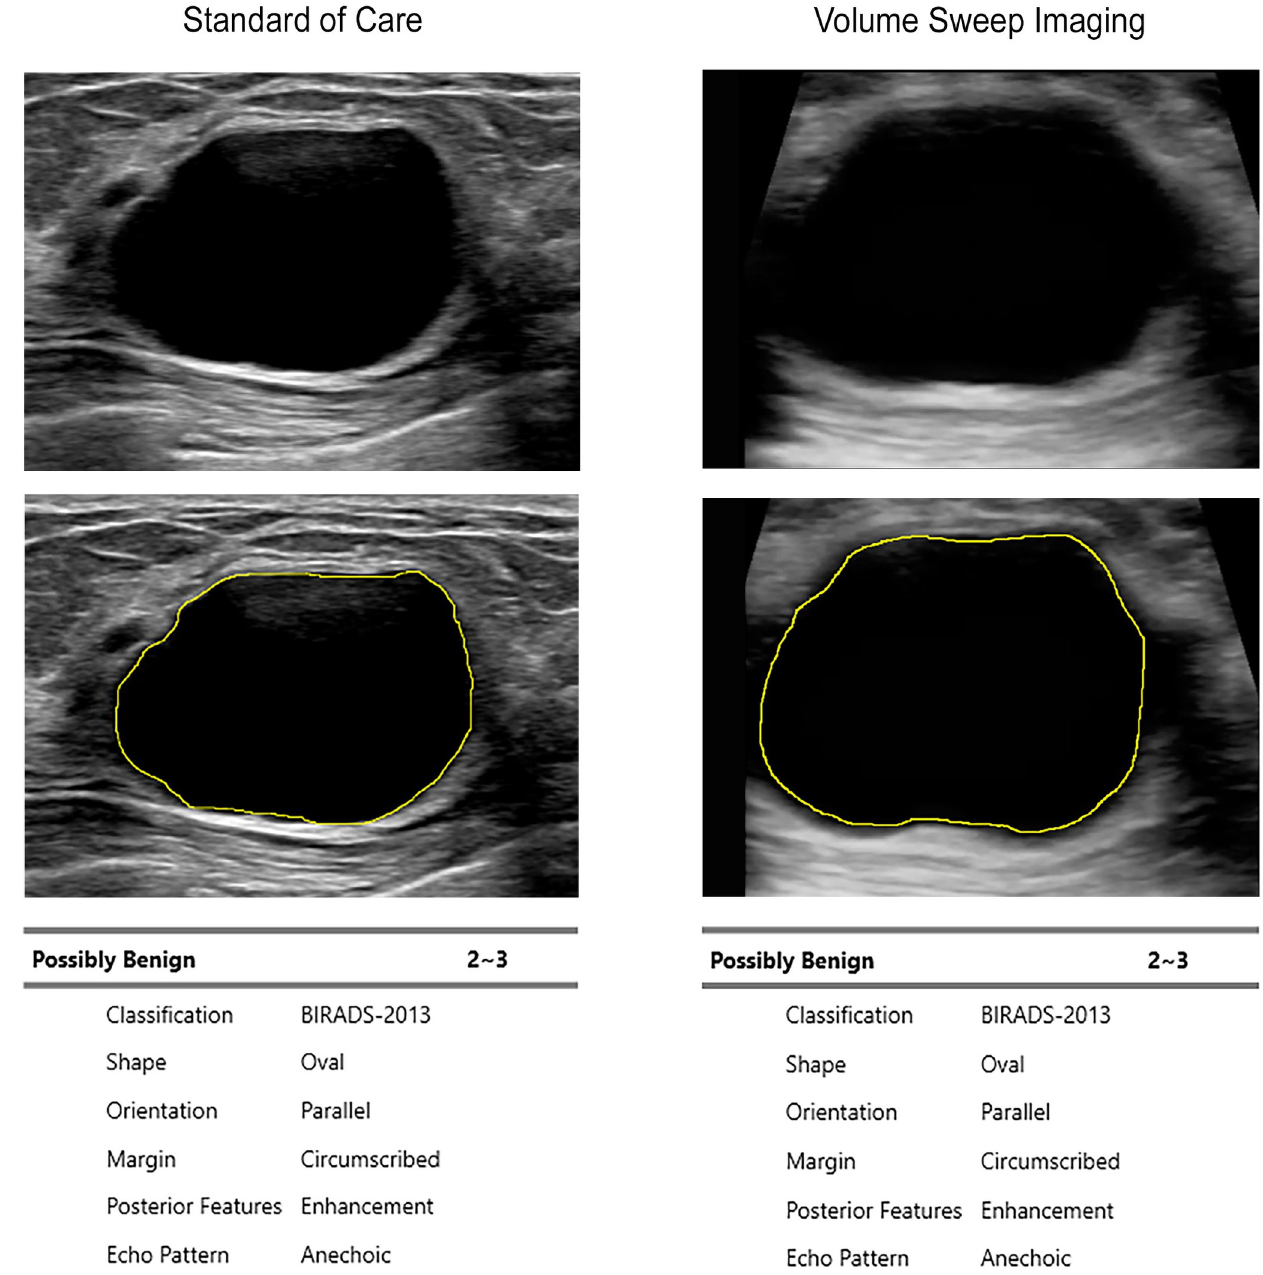
Fig 2. S-Detect Interpretation of a Cyst on Standard of Care and VSI. B-mode ultrasound images of a cyst are shown with their respective mass segmentations and S-Detect produced reports. The standard of care image was obtained by a certified expert breast sonographer using a Philips Epiq 7G ultrasound machine. The VSI image was obtained by a medical student without prior medical experience after less than 2 hours of training on a portable Butterfly iQ ultrasound probe. S-Detect results between standard of care and VSI are identical. The S-Detect results were also identical to expert interpretation of standard of care and VSI outside of mass shape which was called round on expert interpretation (a trivial difference). https://doi.org/10.1371/journal.pdig.0000148.g002 (n = 8), there was 88% agreement with S-Detect interpretation of standard of care imaging (n = 7/8) and 63% agreement with S-Detect interpretation of VSI (n = 5/8). Among the entire category of masses classified as fibroadenoma either by pathology or imaging stability there was 92% agreement with S-Detect interpretation of standard of care imaging (n = 22/24) and 88% agreement with S-Detect interpretation of VSI (n = 21/24). Among cysts, there was 78%